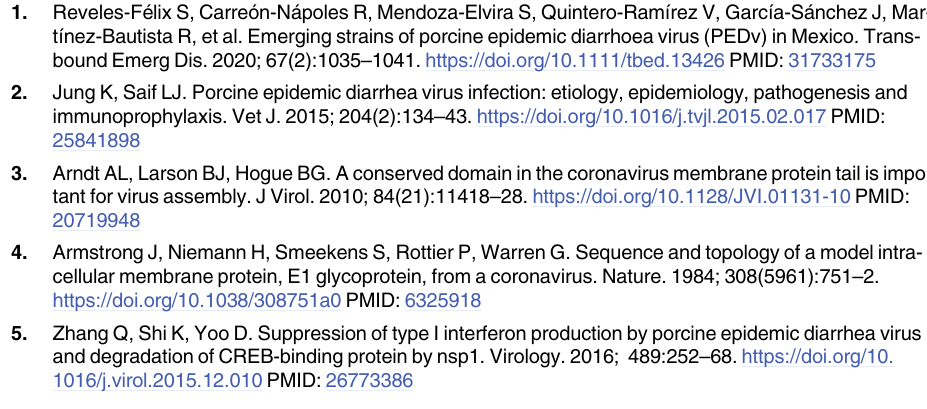
S1 Table. Comparison of the quality of the 3D models of the M proteins from PEDV and SARS-CoV-2. S2 Table. Prediction of discontinuous epitopes with ElliPro in the 3D M protein models. S3 Table. Prediction of discontinuous epitopes with DiscoTope in the 3D M protein mod-